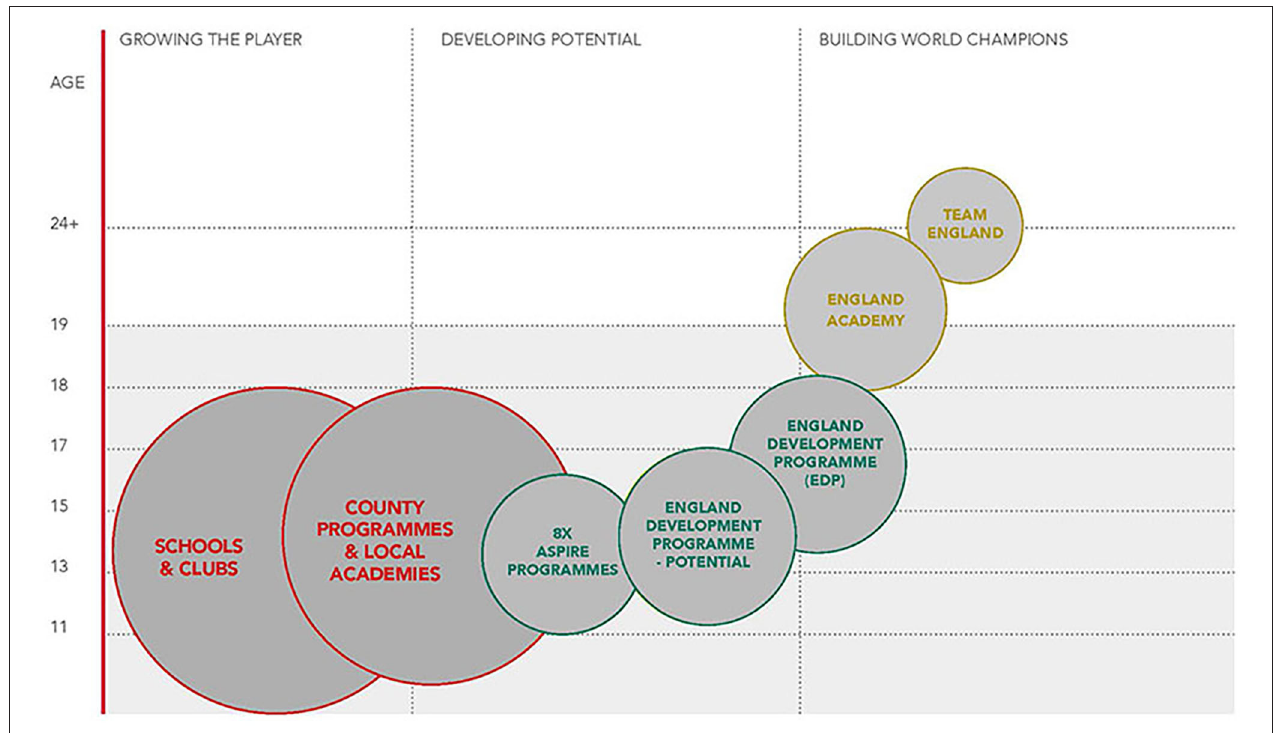
FIGURE 1 | The England Squash talent